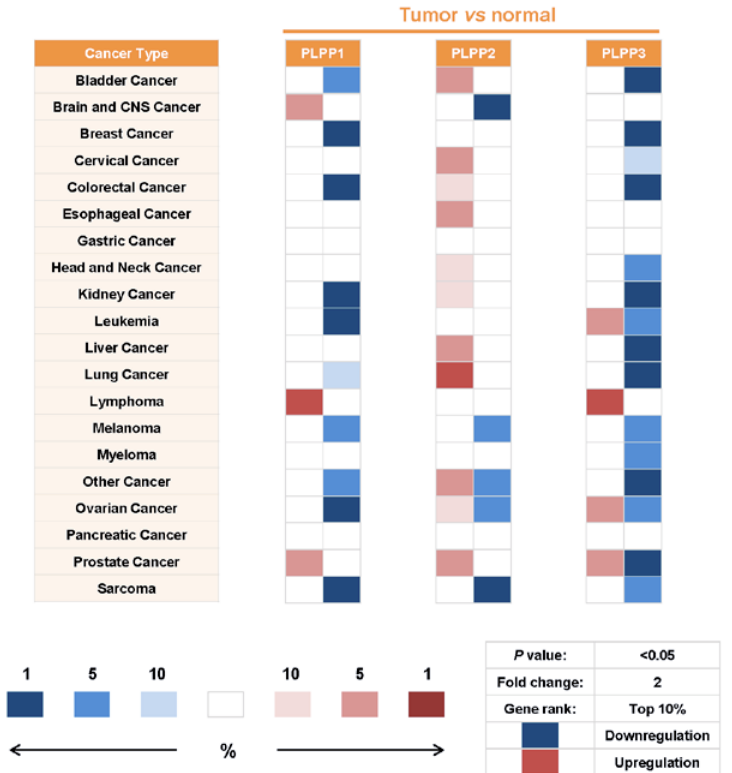
Figure 4. Alterations of mRNA levels of LPP1–3 in different tumors versus normal tissues. Values were obtained from the Oncomine database. The searching thresholds were set as follows: p- value, 0.05; fold change, 2; gene rank, top 10% (means 9% other genes have more significant p- values). The red or blue color represents the up- or downregulation of genes respectively in tumors relative to the adjacent normal tissue. The darkness of color corresponds to the gene rank; darker color means higher rank. LPP1 (PLPP1) and LPP3 (PLPP3) are downregulated, whereas LPP2 (PLPP2) is upregulated in the majority of cancers ( p < 0.05). In some cases, such as PLPP2 in ovarian cancer and other cancers and PLPP3 in leukemia, ovarian cancer, and prostate cancer, both upregulation and downregulation are shown by different datasets. These cases are considered as neither upregulation nor downregulation.